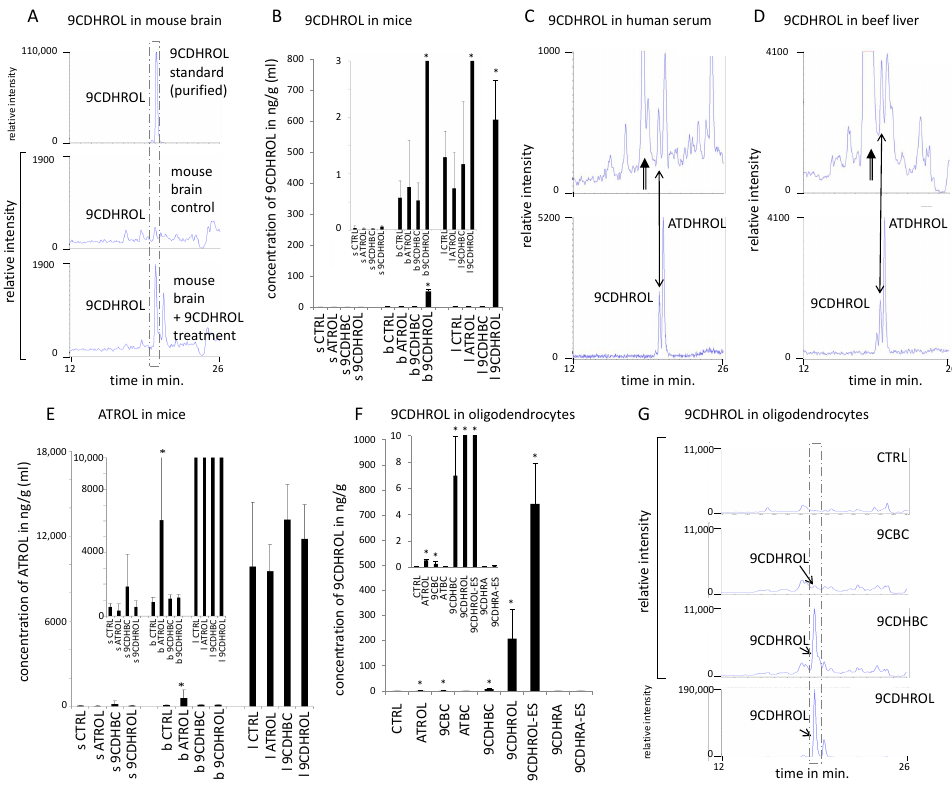
Figure 2. 9CDHROL as a novel endogenous and nutritionally-relevant retinoid . ( A ). 9CDHROL (indicated by a dashed line box) standard (top chromatogram) and endogenous levels in mouse brain (middle chromatogram), and after 9CDHROL- treatment (bottom chromatogram) (§, §§) ($). ( B ). 9CDHROL levels in mouse organs/compartments (each n = 5, s—serum, b—brain, l—liver) after single per os treatment with vehicle for control group (CTRL), or 40 mg/kg of ATROL, 9CDHBC or 9CDHROL ( € ). ( C ). 9CDHROL in human serum (top chromatogram) and 9CDHROL standard mixture including ATDHROL (all- trans -dihydroretinol) (bottom chromatogram) (§§). Double lined arrows indicate unknown peaks and the double sided arrow indicate 9CDHROL in comparison to the standard ($). ( D ). 9CDHROL in human food chain/beef liver (top chromatogram) and 9CDHROL standard mixture including ATDHROL (bottom chromatogram) ($). The double lined arrows indicate unknown peaks and the double sided arrow indicate 9CDHROL in comparison to the standard. ( E ). Concentrations of ATROL in serum (s), brain (b) and liver (l), each n = 5. ATROL levels before and after retinol treatment in serum, brain and liver ( € ). ( F ). 9CDHROL levels including standard deviation in cultured mouse oligodendrocytes after control treatment using ethanol (CTRL) or ATROL-, 9CBC-, ATBC-, 9CDHBC-, 9CDHROL-, 9CDHROL-ES-, 9CDHRA- or 9CDHRA-ES-treatment, each at 10 − 6 M and n = 3 ( € ). ( G ). Conversion of 9CDHBC and 9CBC to 9CDHROL (indicated by a dashed line box) in mouse oligodendrocyte cell line in vitro after ethanol (CTRL) or 9CBC, 9CDHBC and 9CDHROL administration (§,